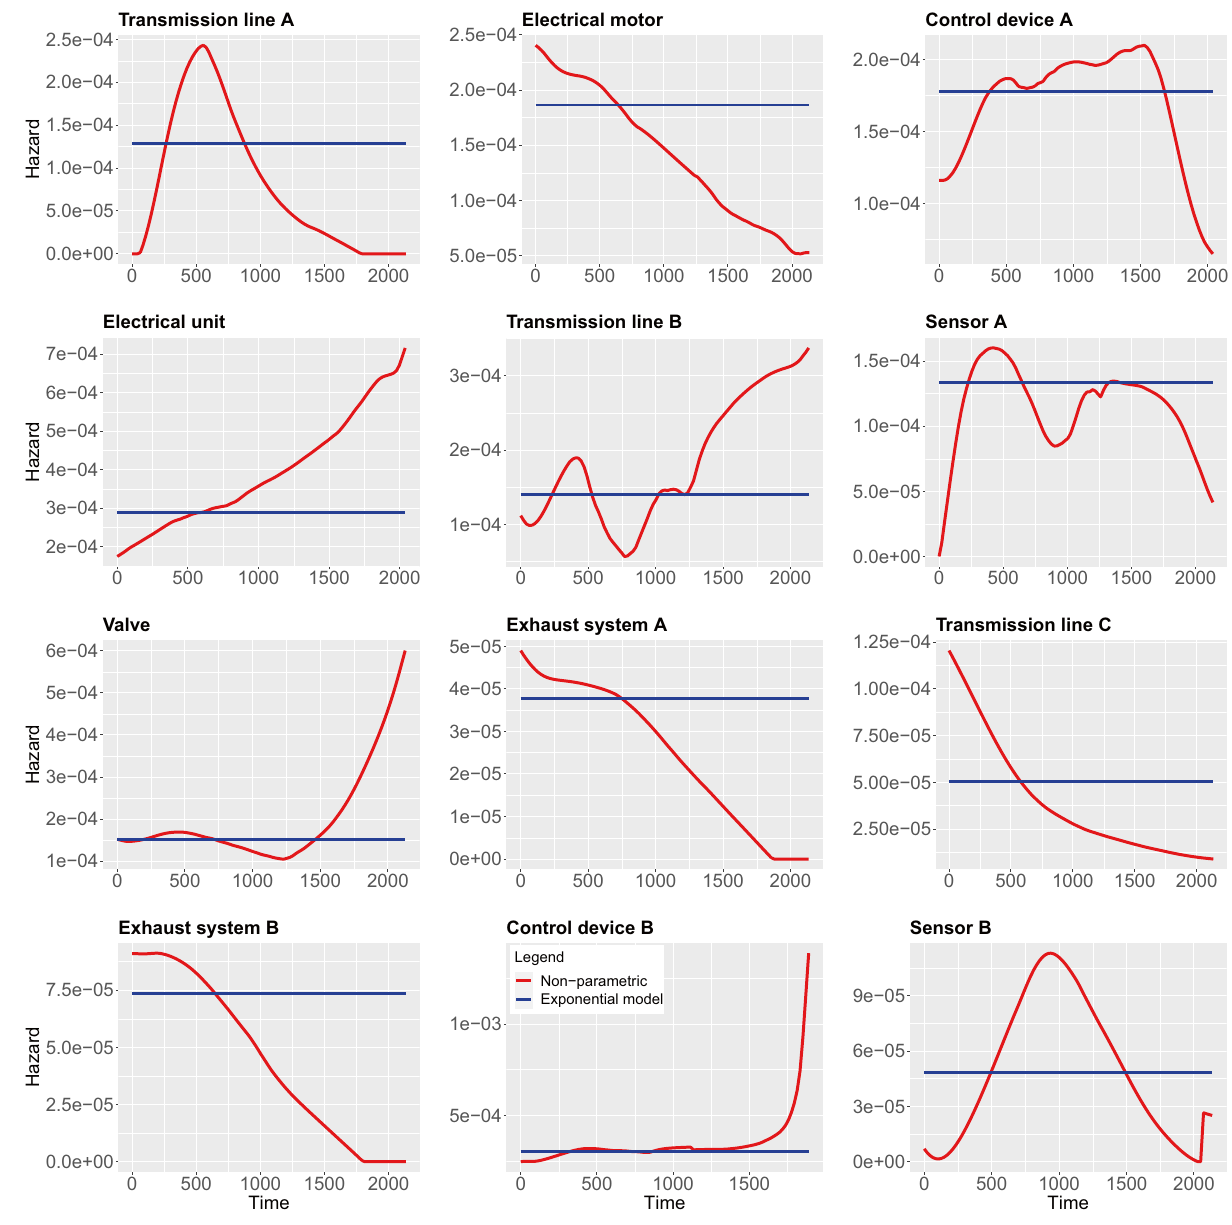
Figure 8. Exponential model hazard. Blue curve indicates Exponential model hazard and red curve represents non-parametric kernel-estimator